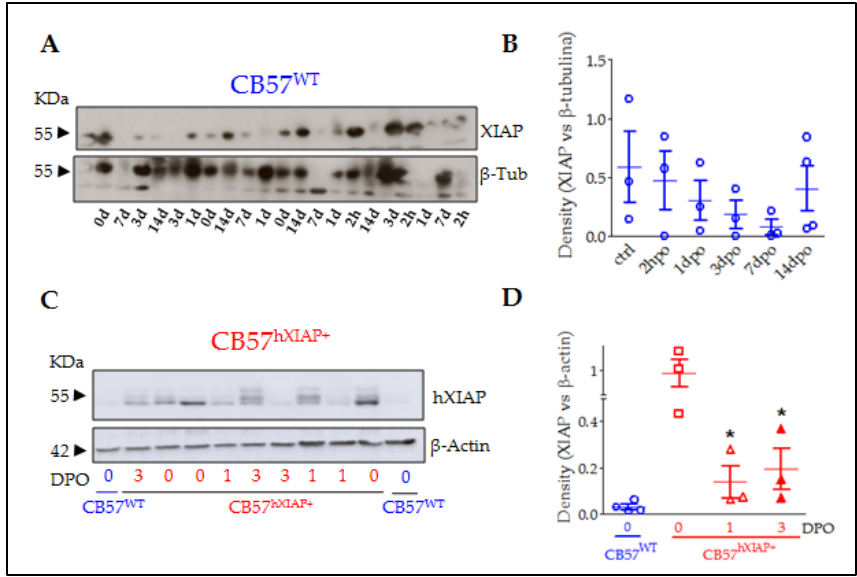
Figure 1. XIAP expression in the spinal cord of CB57 WT and CB57 hXIAP+ mice was reduced after SCI. Representative immunoblot of XIAP levels in CB57 WT ( A ) and hXIAP in both CB57 WT and CB57 hXIAP+ ( C ) mouse spinal cord samples. Band densitometry (relativised to the loading control) reveals that SCI induces a decrease in endogenous XIAP and human hXIAP expression in CB57 WT ( B ) and CB57 hXIAP+ ( D ) mice, respectively (* = p -value < 0.05 in Student ’ s t-test n = 3-4 animals/group)